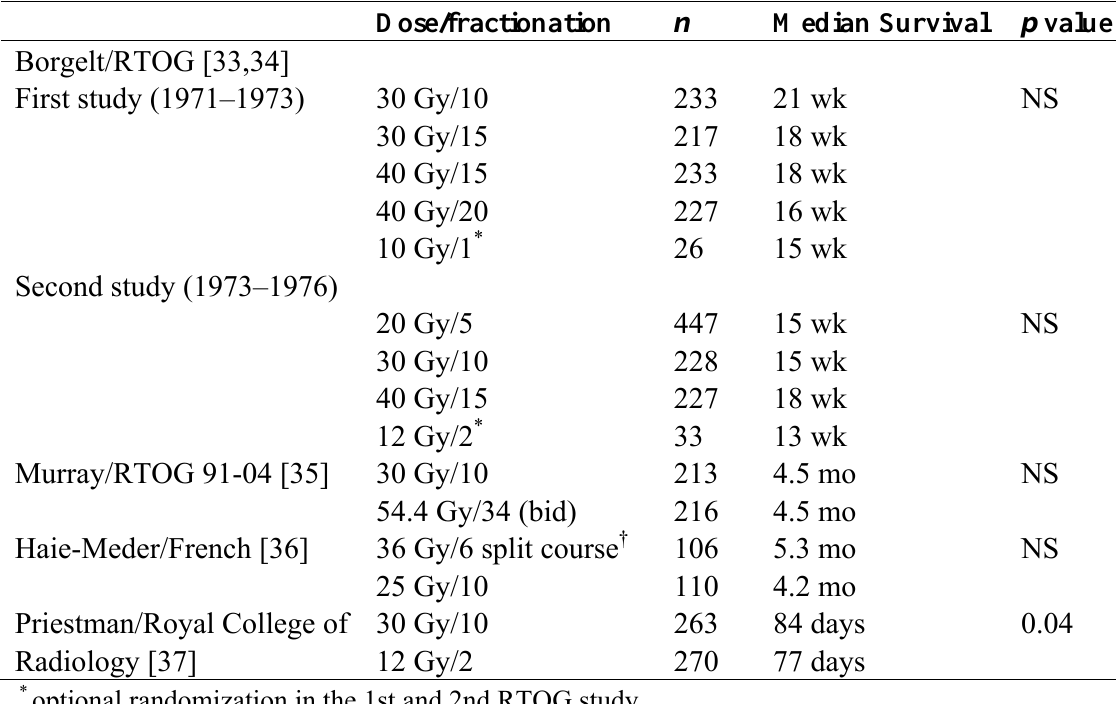
Table 3. Selected randomized trials of various dose fractionation regimens for